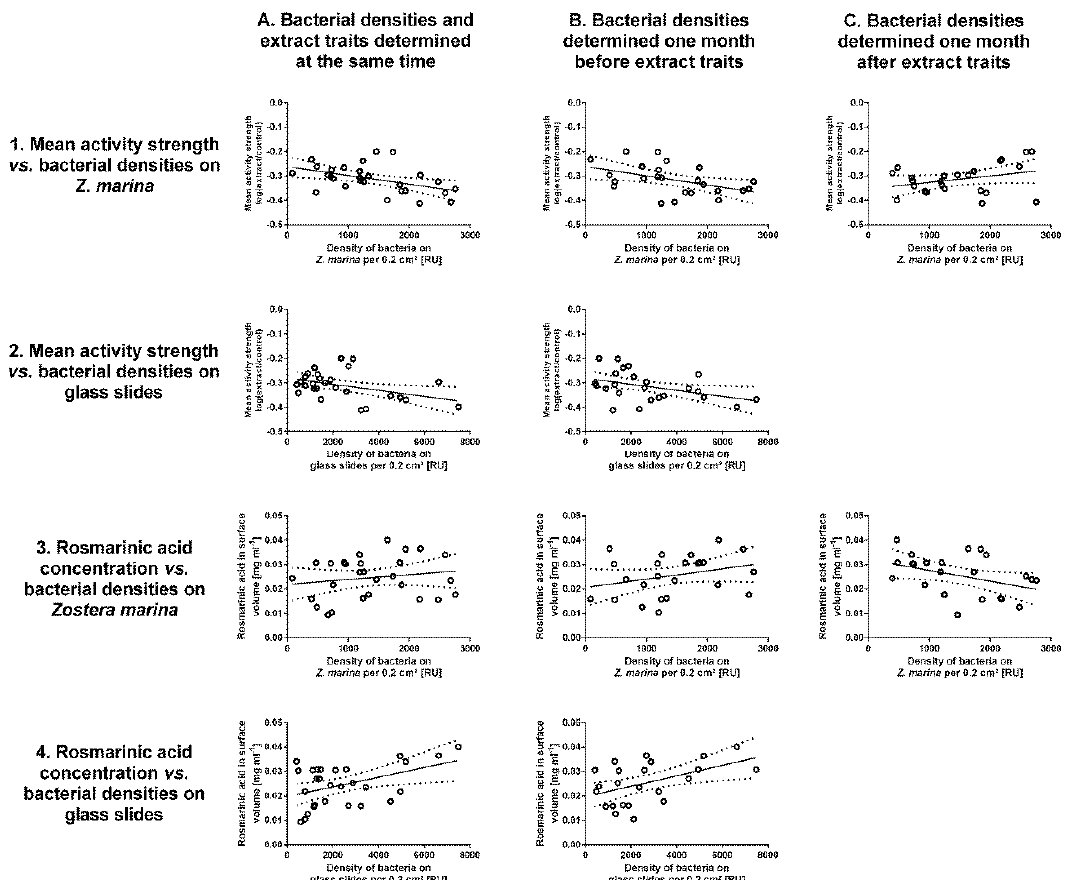
Figure 4. Pearson correlations of bacterial densities on Z. marina (rows 1 and 3) and on glass slides (rows 2 and 4) with the mean activity strength of Z. marina surface extracts against bacterial isolates (rows 1 and 2) and the rosmarinic acid concentration in these extracts (rows 3 and 4). In column (A), bacterial densities were correlated with the traits of extracts sampled in the same month. In (B), bacterial densities were correlated with the traits of extracts sampled one month later (=lagged responses). In (C) bacterial densities were correlated with the traits of extracts sampled one month earlier. Lines represent best fitting linear functions, dotted lines indicate their 95% confidence intervals. For coefficients r of all correlations compare to Table 4.